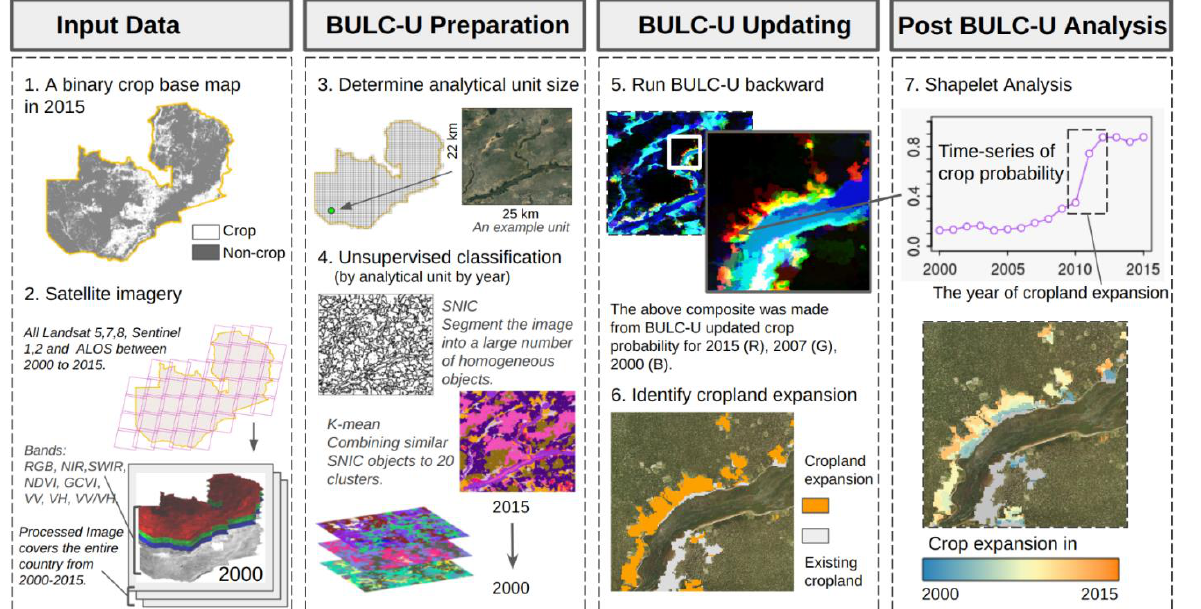
Figure 2. An overview of our research workflow, which begins with the preparation of input datasets. ( 1 ) Crop class extracted as mask from GFSAD. ( 2 ) Yearly optical and radar imagery spatially filtered and pre-processed. ( 3 ) Identification of minimum mapping unit. ( 4 ) Cluster identification using a K–means classifier and segmentation. ( 5 ) BULC–U Algorithm executed in descending order from 2015. ( 6 ) Determination of yearly cropland probabilities and expansion given the slope threshold ( 7 ) Determination of statistically significant shapelets of crop expansion over